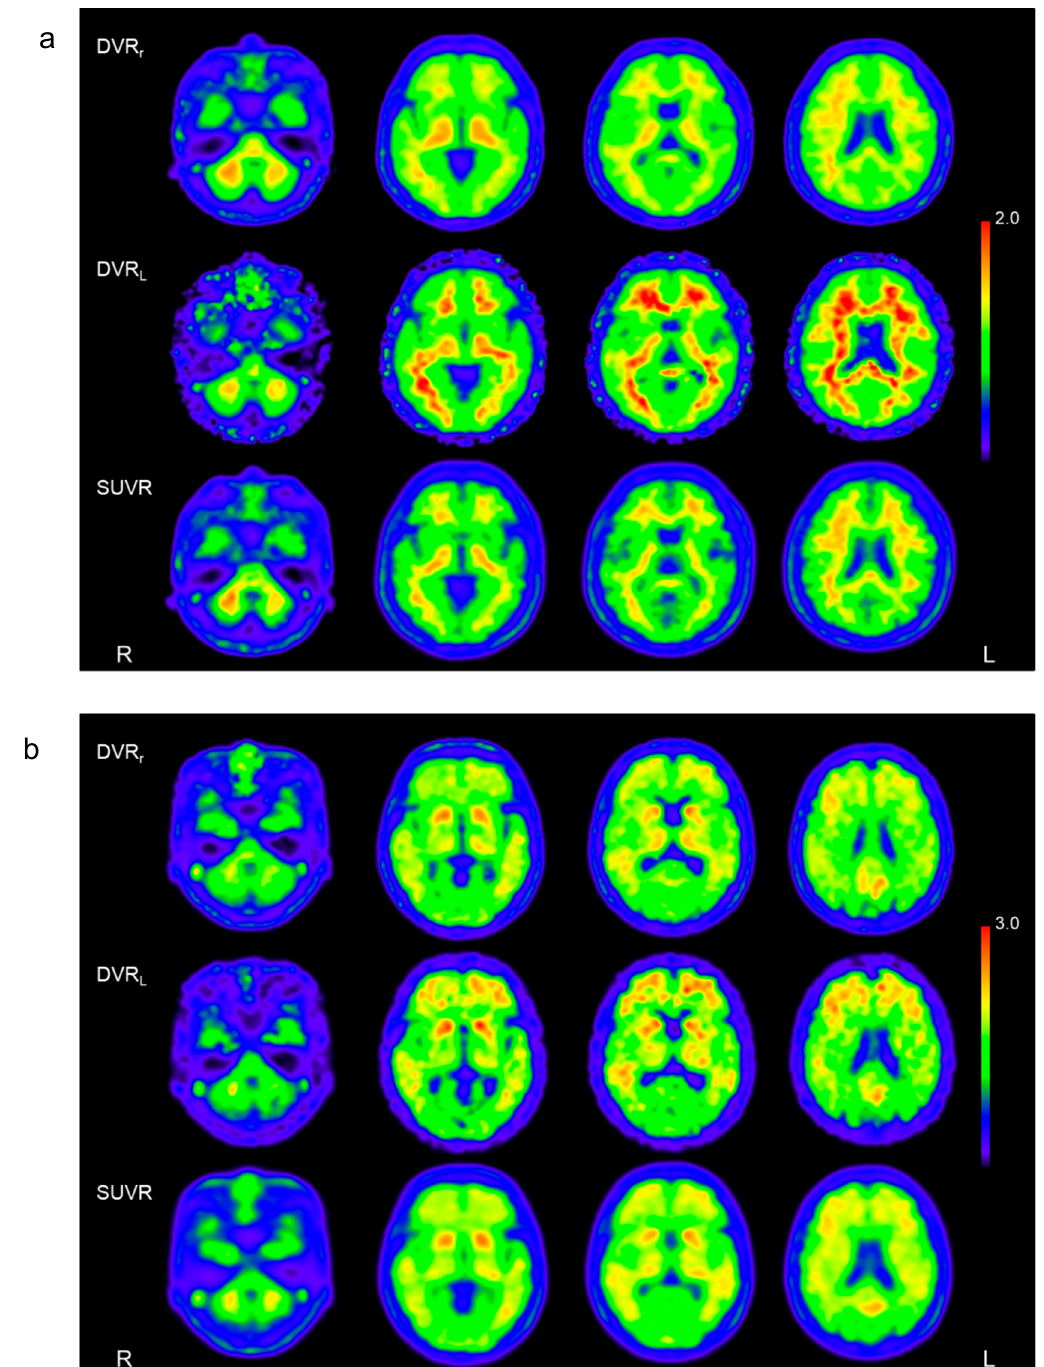
Figure 3. Representative images calculated from the [ 11 C]PiB PET data of CTL ( a ) and eAD subjects ( b ). Iimages of distribution volume ratio calculated using the Logan plot method (DVR L ) and metabolite-corrected IDIF (middle row) showed better contrast for both groups compared with distribution volume ratio from the reference tissue graphical method (DVR r ) and standardized uptake value ratio (SUVR) (upper and bottom row, respectively). Table 1. Regional DVR (mL/min/100 g) and SUVR values (mean ± SD).